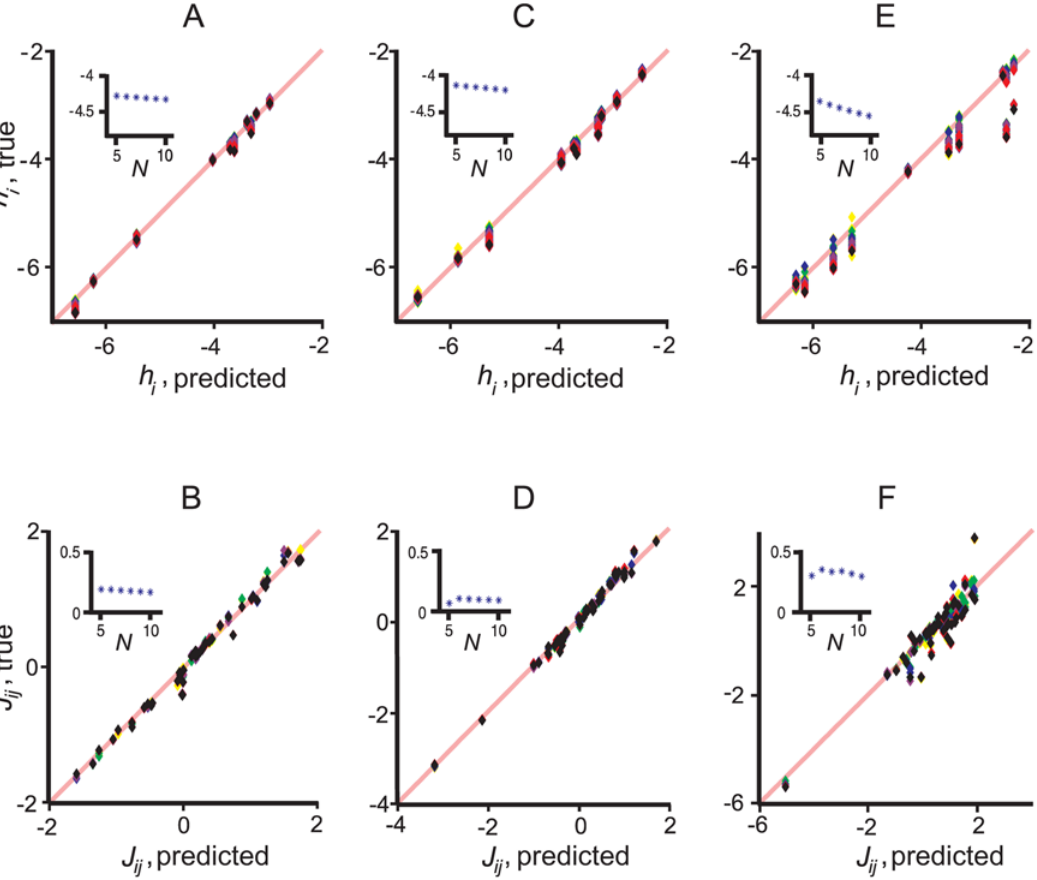
Figure 6. The true external fields and pairwise interactions compared with the predictions of the perturbation expansion. The top row shows the true external fields, h i , versus those predicted from Eq. (18a), and the bottom row shows the true pairwise interaction, J ij , versus those predicted from Eq. (18b). Values of N ranging from 5 to 10 are shown, with different colors corresponding to different N s . For each value of N , data is shown for 45 realization of the true distribution. Insets show the N - dependence of the mean external fields (top) and mean pairwise interactions (bottom). The three columns correspond exactly to the columns in Fig. 5. (A, B) ( nd t ~ 0 : 024 ). There is a very good match between the true and predicted values of both external fields and pairwise interactions. (C, D) ( nd t ~ 0 : 029 ). Even though nd t has increased, the match is still good. (E, F) ( nd t ~ 0 : 037 ). The true and predicted external fields and pairwise interactions do not match as well as the cases shown in (A, B, C, D). There is also now a stronger N - dependence in the mean external fields compared to (A) and (B). The N - dependence of the pairwise interactions in (F) is weaker than that of the external fields, but still notably stronger than the ones in (B) and (D). This indicates that the perturbative expansion is starting to break